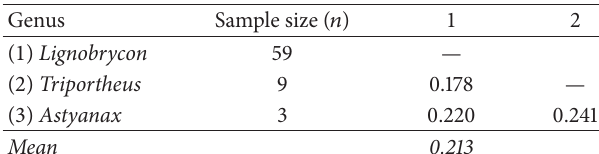
Table 1: Genetic distance of COI sequences among genera based on K2P model.